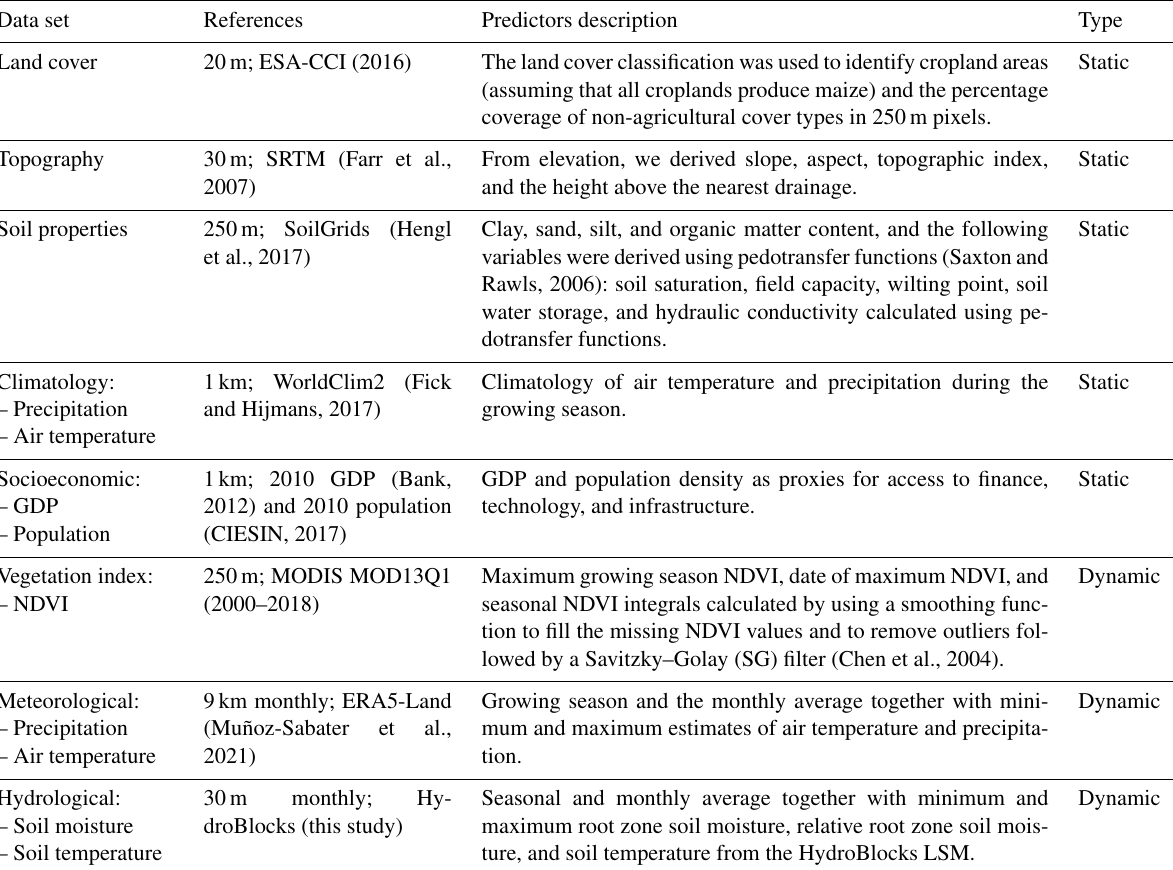
Table 1. List of the data sets and the predictors derived to train the random forest model. Data